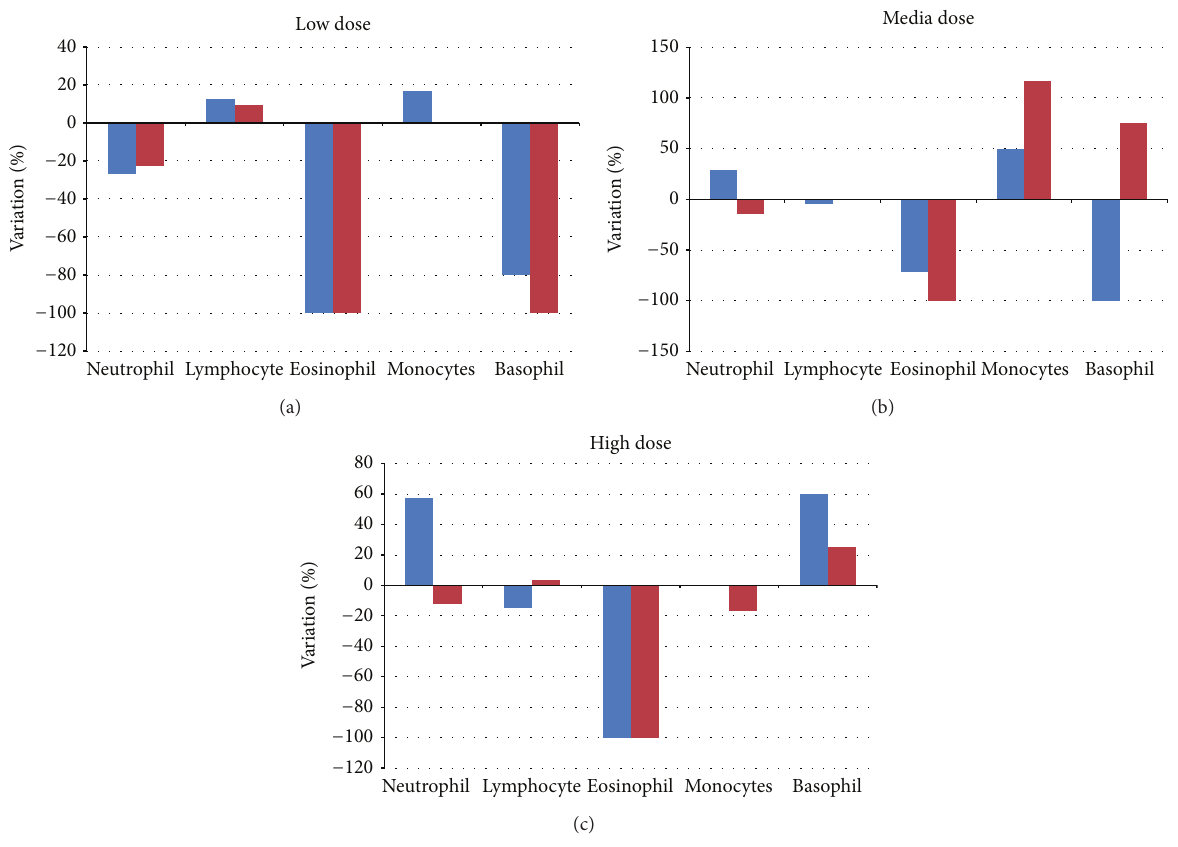
Figure 13: Percentage of variation in every Leukocyte categories compared to the negative control mice treated with the lowest ceria NPs concentration (a), media ceria NPs concentration (b), and the highest ceria NPs concentration (c).